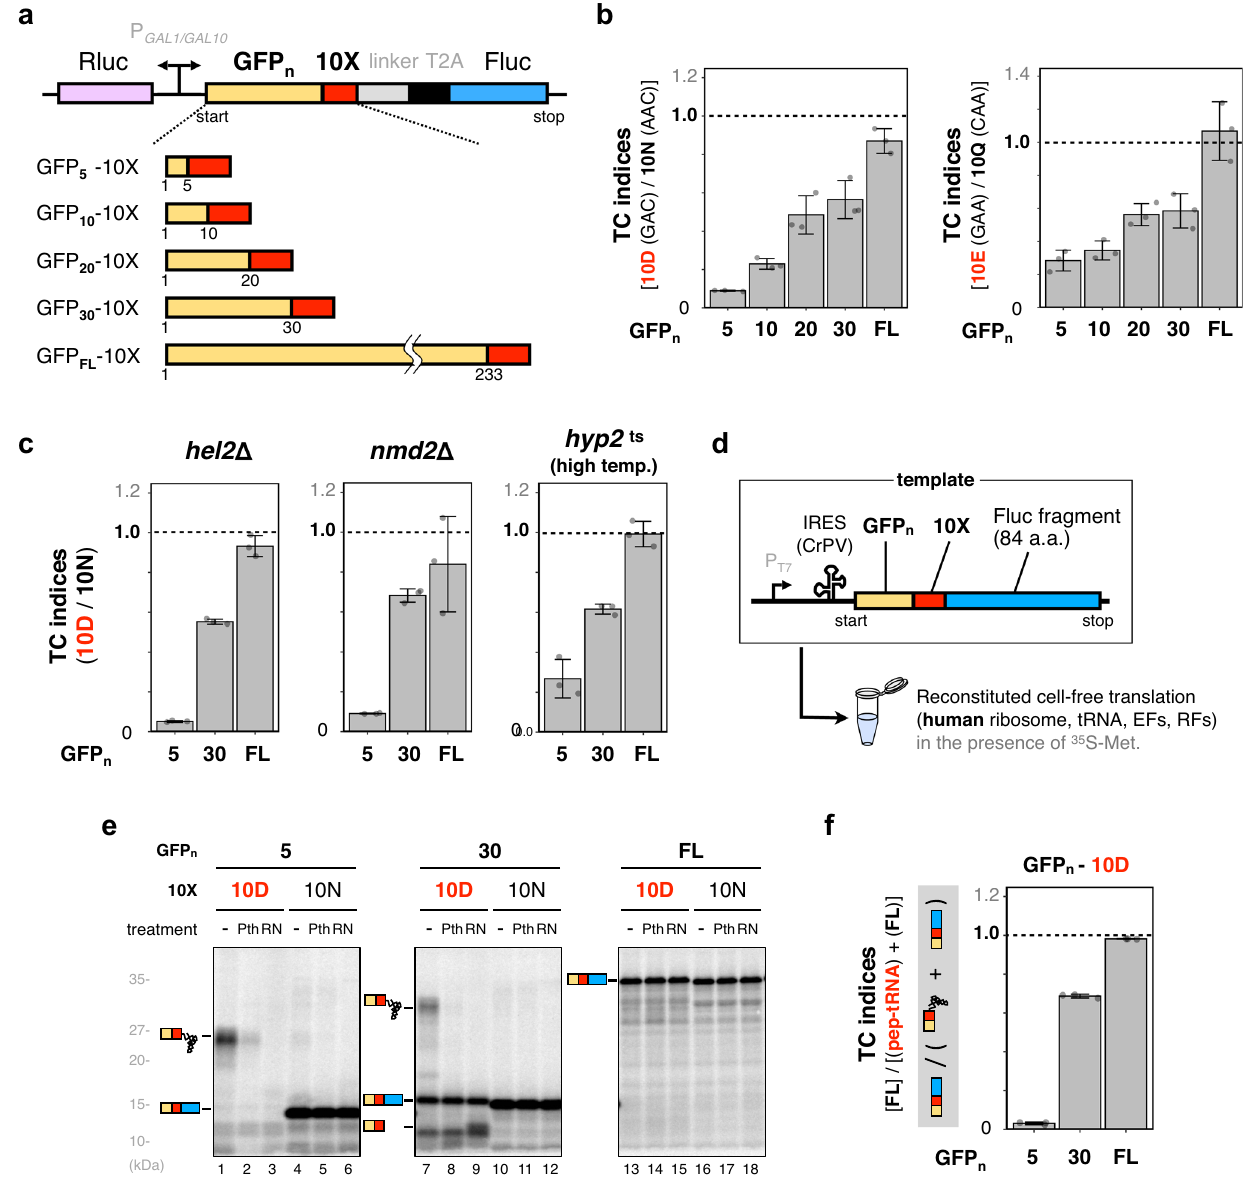
Fig. 1 | Consecutive negatively charged amino acids in the N-terminal regions prematurely terminate translation. a Schematic representation of the dual- luciferase assay. Homo-decamers of amino acids (10X) were inserted between varying lengths of the N-terminal region of GFP (GFP n ; n =5, 10, 20, 30, and 233 as full-length:FL)andalinker.Fire fl y(Fluc)and Renilla (Rluc)luciferaseswereusedas reporter enzymes to investigate the translation continuation and an internal translation control, respectively. The GAL1-GAL10 promoter is a galactose- inducible bidirectional promoter. T2A is the self-cleaving peptide from Thosea asigna virus 2A 77 . b The translation ef fi ciencies of ORFs harboring 10X in S. cere- visiae were evaluated by the reporter system shown in a . After induction by galactose, the translation ef fi ciencies weremeasured as the relative activity of Fluc to that of Rluc. Translation continuation (TC) indices were calculated by the fol- lowing formula: {Fluc activity/Rluc activity (10D)} / {Fluc activity/Rluc activity (10N)}. Error bars indicate standard deviations (SD) from three biological repli- cates. The codons encoding 10X are indicated in parentheses. c TC indices eval- uated using the reporter system in the hel2 Δ , nmd2 Δ , and hyp2 temperature-